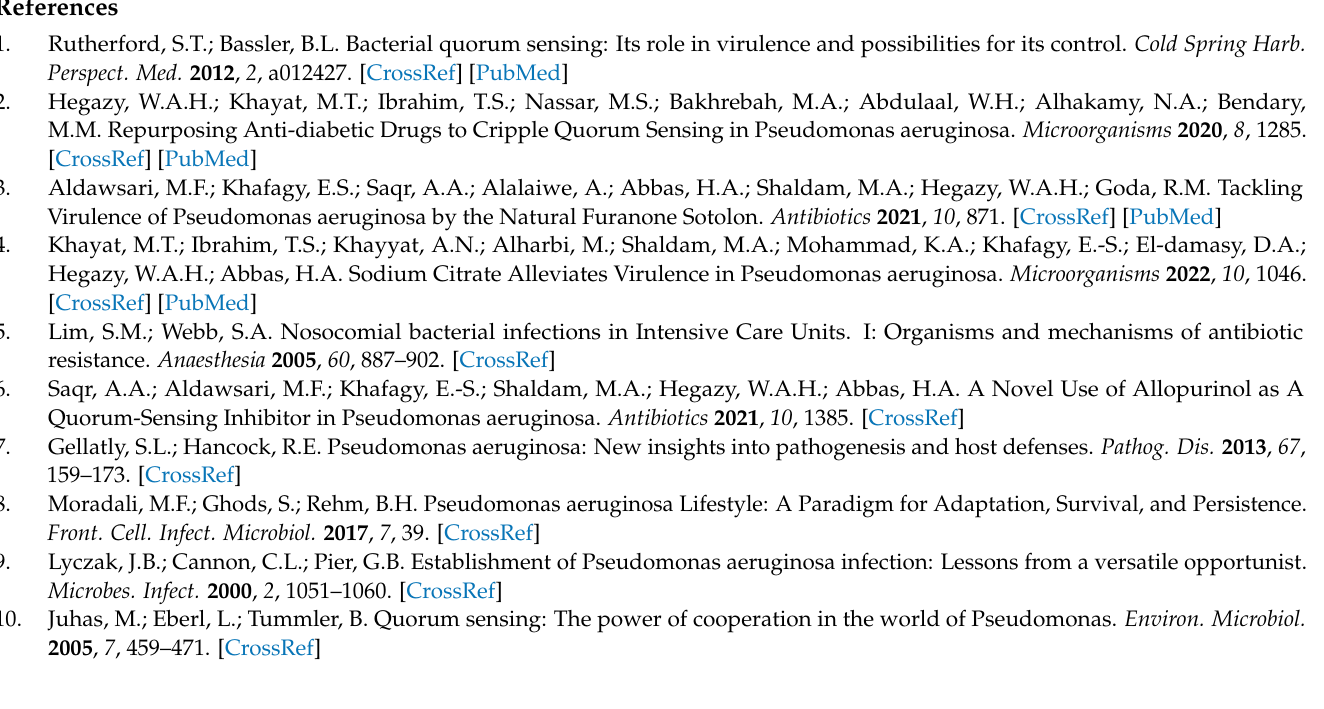
Table S1: Descriptive P. aeruginosa LasI-ligand binding interactions via docking protocol; Table S2: Descriptive P. aeruginosa QscR-ligand binding interactions via docking protocol; Table S3: Descriptive P. aeruginosa LasR-ligand binding interactions via docking